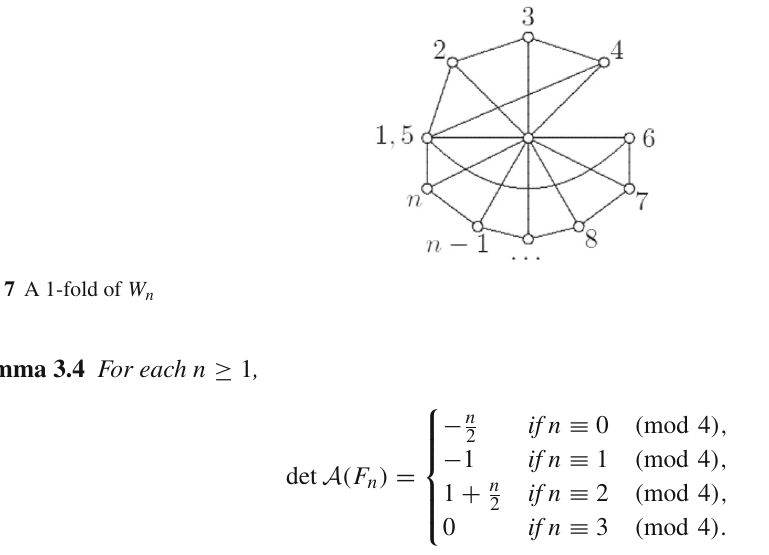
Fig. 7 A 1-fold of W